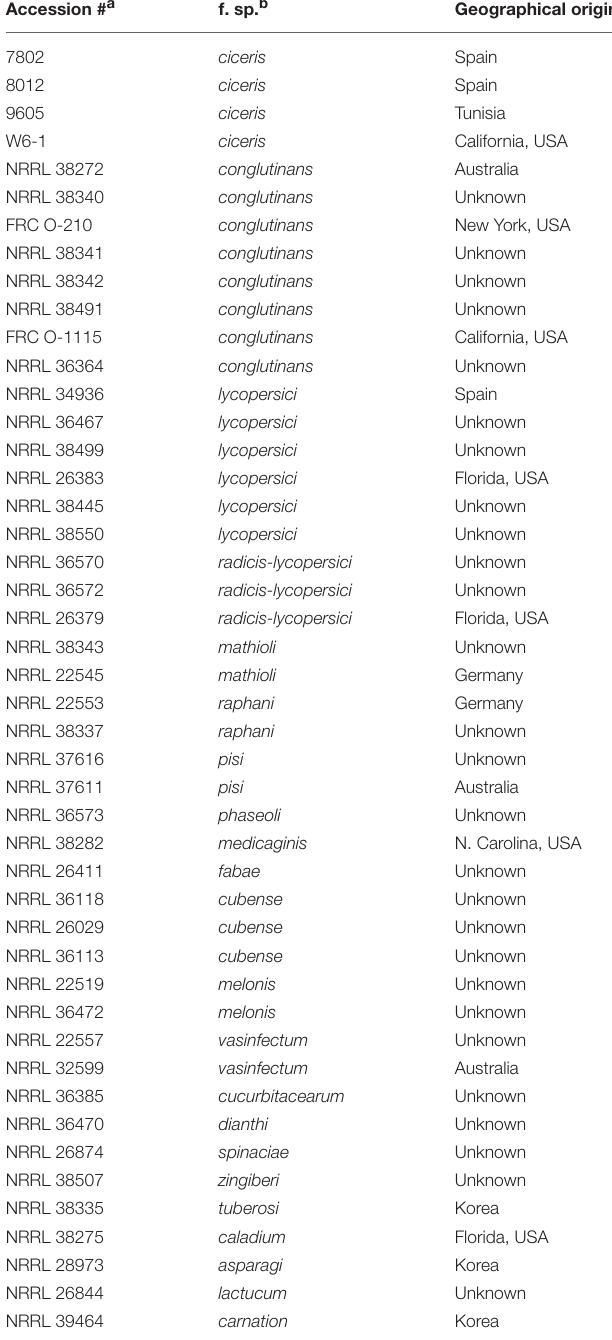
TABLE 1 | F. oxysporum strains screened in this